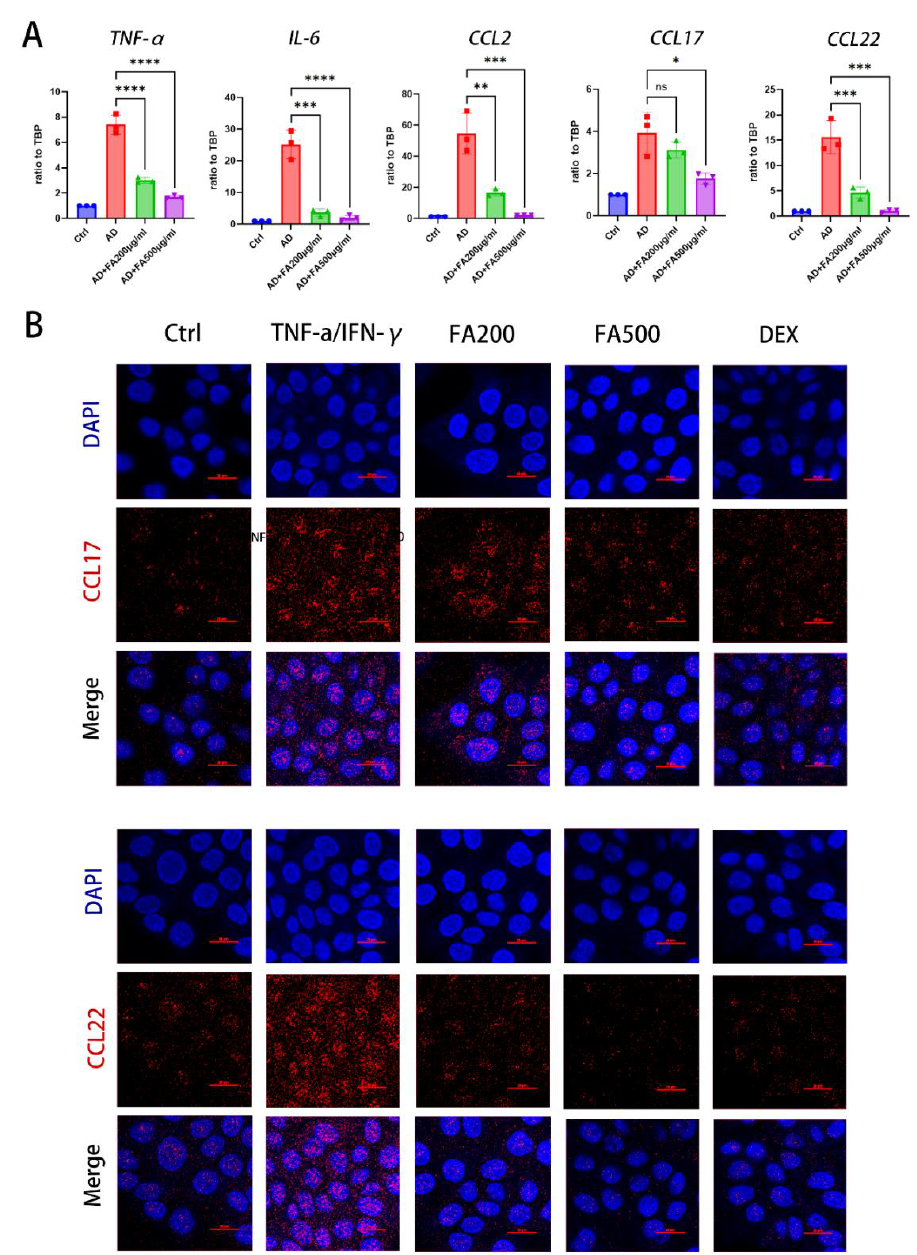
Figure 2. Effects of FA on cytokine mRNA expression in TNF- α /IFN- γ -stimulated HaCaT cells. FA (200 and 500 g/mL) was applied to the cells for 30 min, followed by TNF- α /IFN- γ (10 ng/mL) for 20 h (qRT-PCR) or 30 min (ICC). ( A ) The levels of mRNA expression were evaluated using RT-PCR after extracting the total RNA. ( B ) After 30 min of stimulation, the protein levels of CCL17 and CCL22 were assessed using the intensity of the ICC stain. The positive control was dexamethasone (Dex, a glucocorticoid used for AD). The image scale is 100 um. A minimum of three experiments were used to calculate the mean ± SEM. **** p < 0.0001, *** p < 0.001, ** p < 0.01, * p < 0.05, ns stands for not significant.